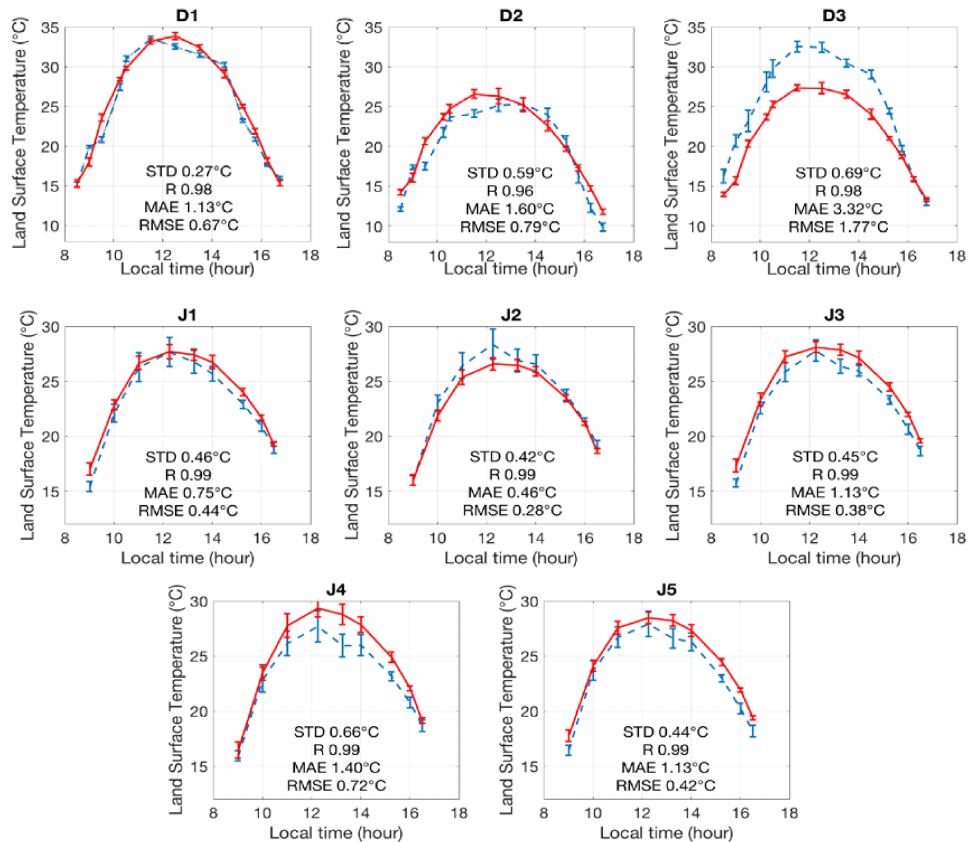
Figure 4. Diurnal cycle of UAV-based LST (blue dashed line) versus in situ temperature as measured by Apogee sensors (red line) for the December (D1–D3) and January (J1–J5) campaigns, along with statistics including the in situ LST standard deviation (STD), correlation coefficient (R), mean absolute error (MAE) and root mean square error (RMSE).